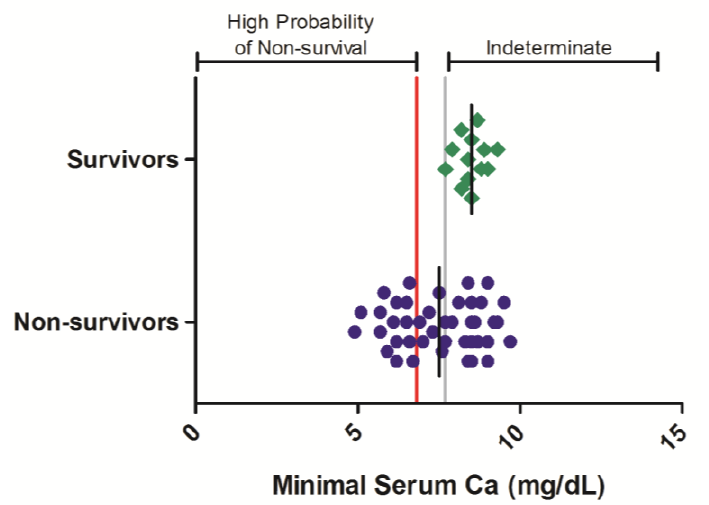
Figure 3. Serum GGT responses in rhesus monkeys exposed to Ebola virus. Symbols represent the maximal serum GGT value obtained at any time during the course of infection for an individual animal (diamonds = survivors, circles = non-survivors). Data were compiled from multiple independent historic experiments. The horizontal gray line indicates a survival threshold, i.e. , the maximal value obtained in any animal that survived infection. The red line indicates a proposed euthanasia threshold value based on ROC curve suggested values plus 10%. Black lines are the group mean. Normative serum GGT reference range for rhesus monkeys (mean +/− 1 SD) is 66–97 U/L [21].